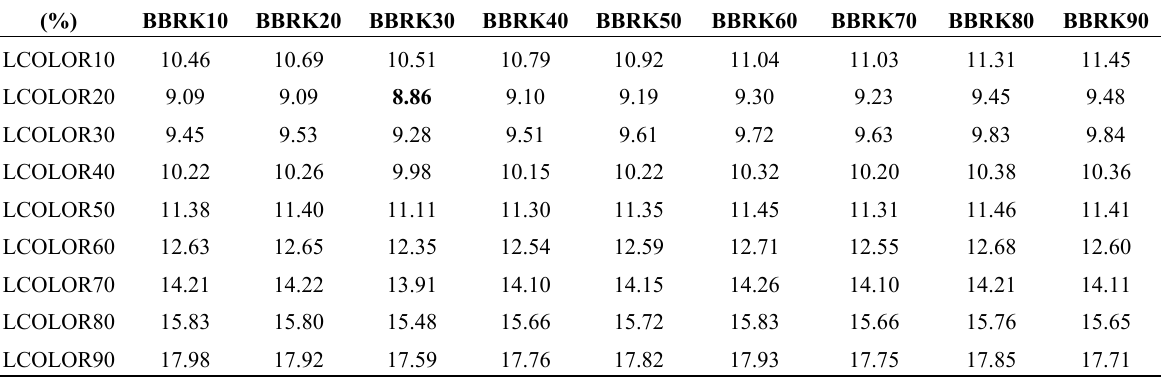
Table 2. Mean percentage error between simulated and observed LAI for different